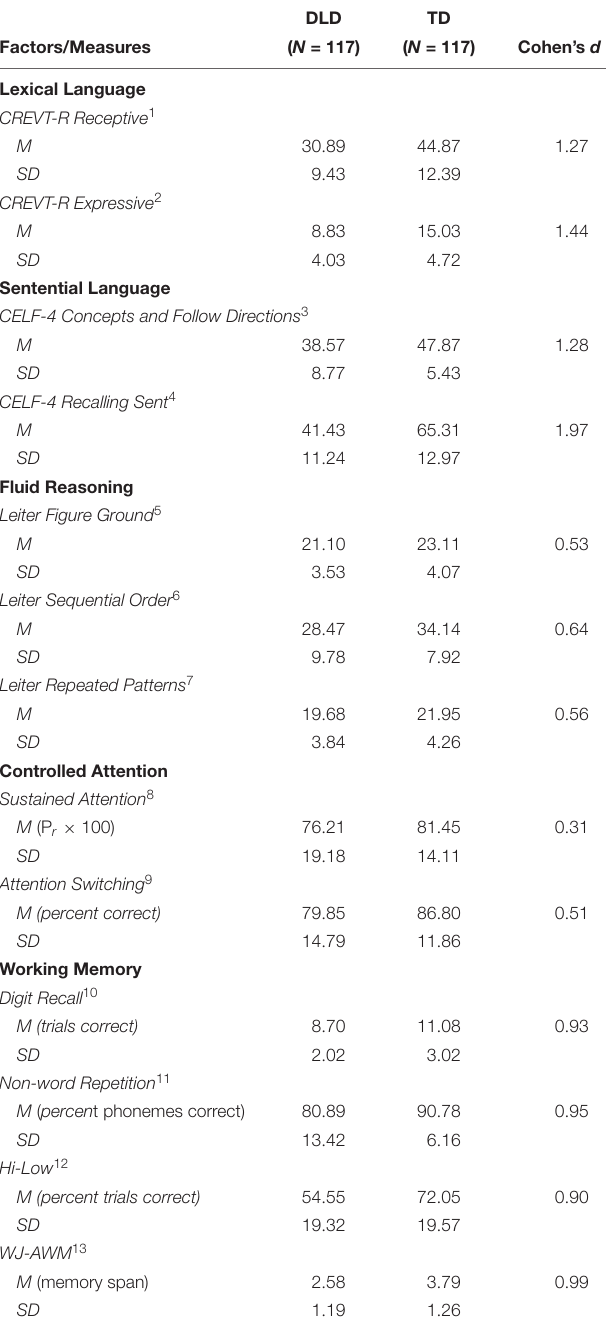
The sequential order subtest of the Leiter-R (Roid and Miller, 1997) served as an index of children’s ability to recognize and use serial order patterns in the service of solving a visual processing task. The assumption was that serial order processing was required because children look at logical progressions of